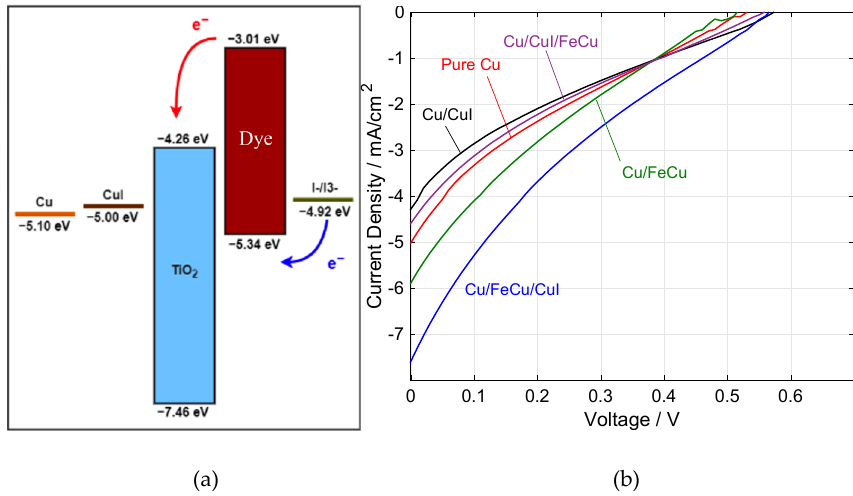
Table 2. Performance characteristics of DSSC constructed using all negative electrode structures. Negative electrode structure